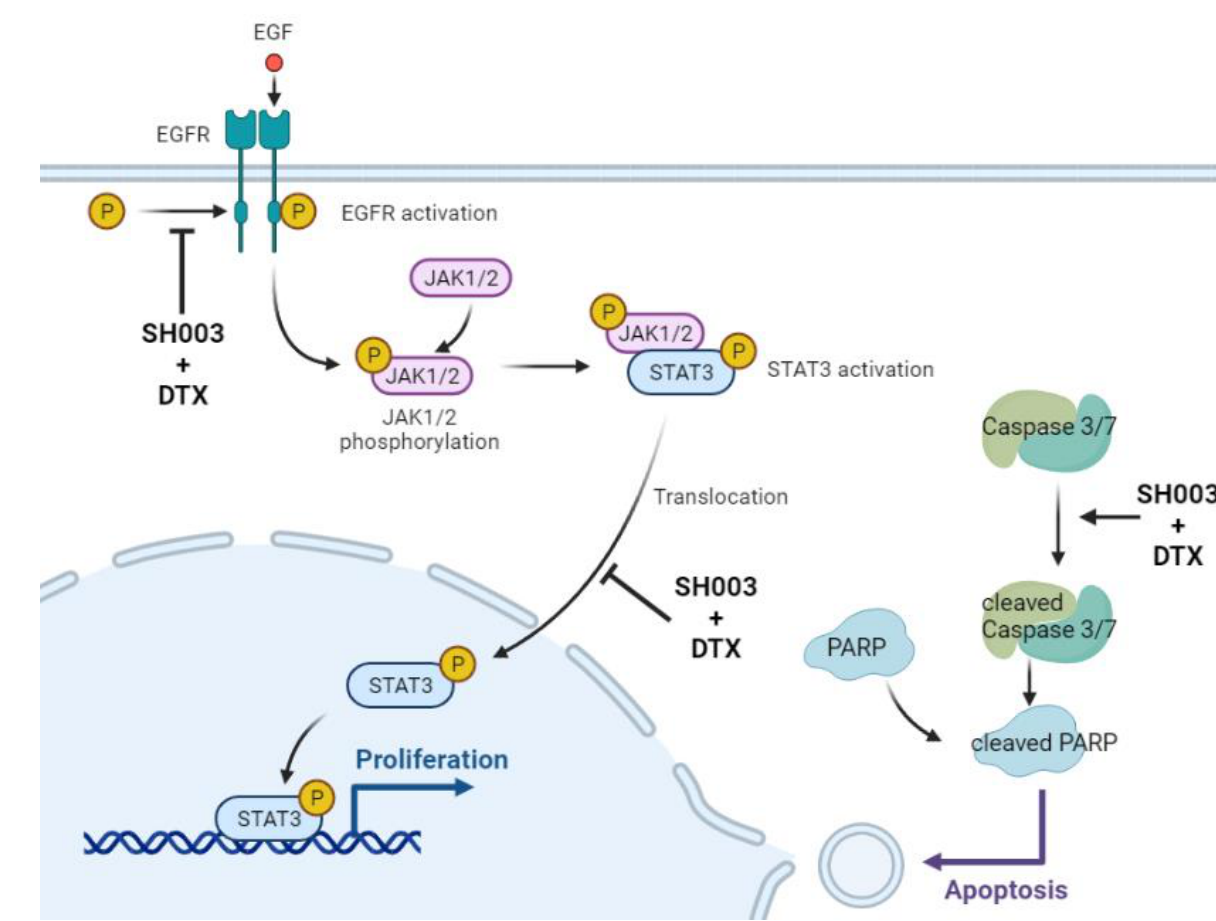
Figure 6. Overview of the proposed anticancer mechanism of SH003 in combination with DTX in H460 cells.